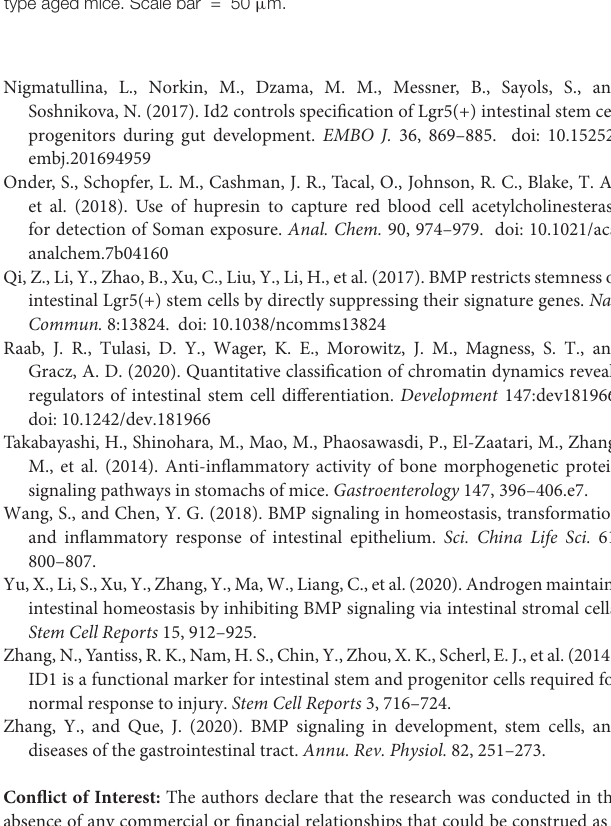
Supplementary Figure 1 | (A) rtPCR verifying the expression of Hadh, Ifi204, Srpk1, Smad4 in the colon of DSS-induced colitis at day 0, 3, 5. (B) KEGG analysis the differential protein related pathway. (C) rtPCR show the expression of BMP2,4,7 in the colon of DSS-induced colitis at day 0, 3, 5. Data represent